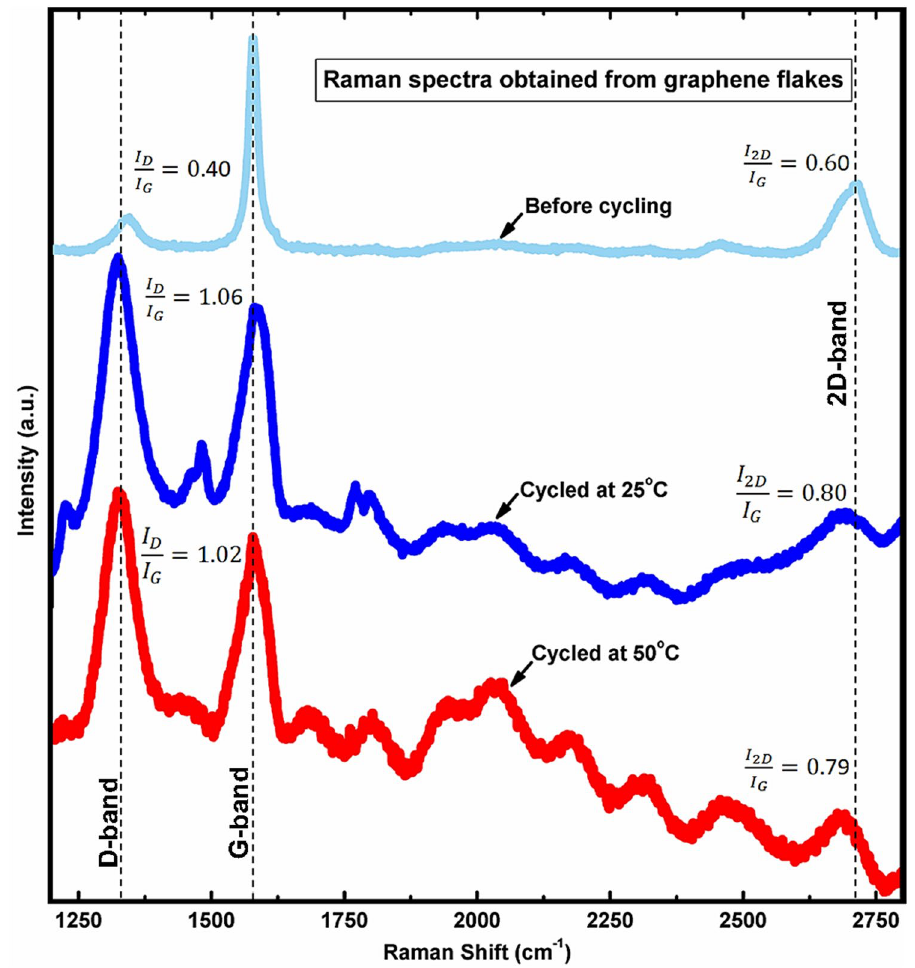
Fig. 6 Raman spectra obtained from graphene nanoflake-based anodes before cycling and after 50 cycles at 25 and 50